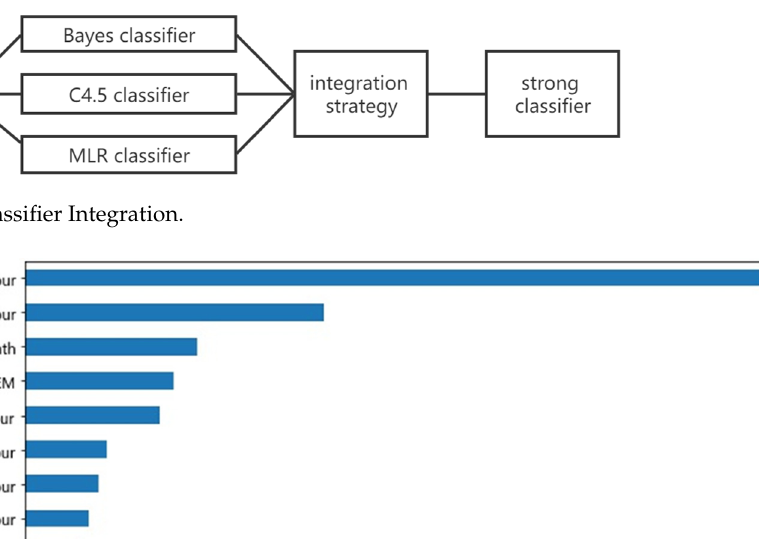
Figure 2. Base Classi fi er Integration.